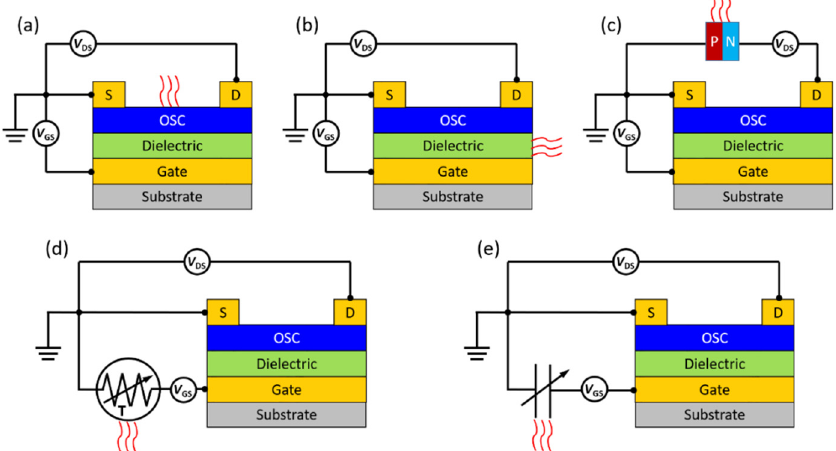
Figure 3. OFET-based temperature sensors with different sensing elements: ( a ) OFET active layer [39]; ( b ) dielectric layer [40]; ( c ) separate diode (shows the diode direction of the p-channel OFET) [41]; ( d ) separate thermistor [42]; ( e ) separate capacitor [43].